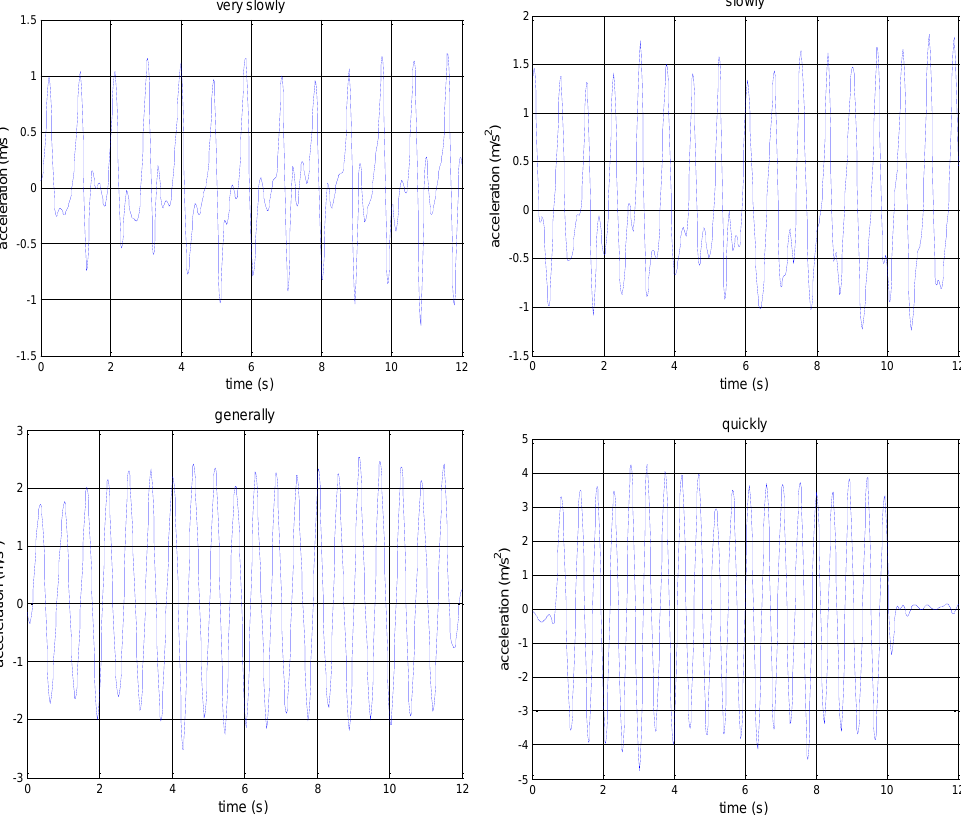
Figure 4. Acceleration modulus of different walking